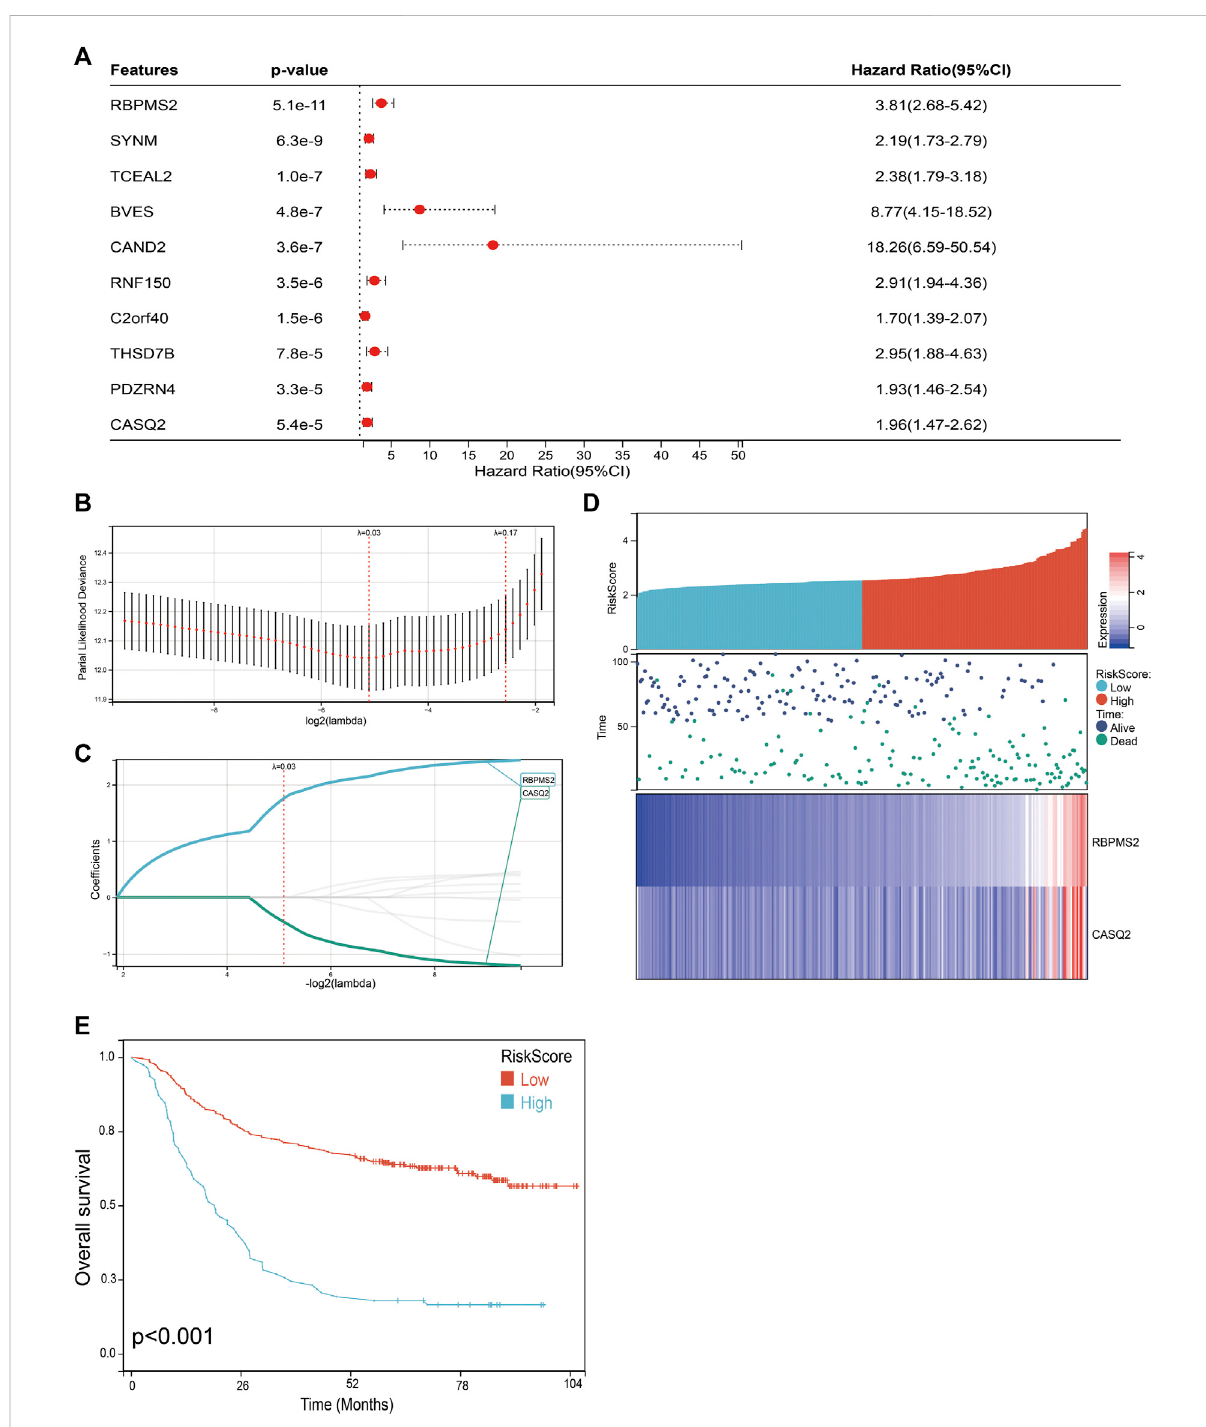
FIGURE 8 Construction of a classi fi er to predict OS for gastric cancer patients. (A) Univariate Cox regression analysis was used to assess the genes that related to prognosis. (B) Partial likelihood deviation of the OS of the LASSO coef fi cient pro fi le. (C) LASSO coef fi cient curves of RBPMS2 and CASQ2expressions. (D) Thedistributionofriskscore,survivalstatus,andmRNAexpressionlevelsofgastriccancerpatientsinGSE62254database. (E) Kaplan-Meier curves to compare overall survival of low-risk and high-risk